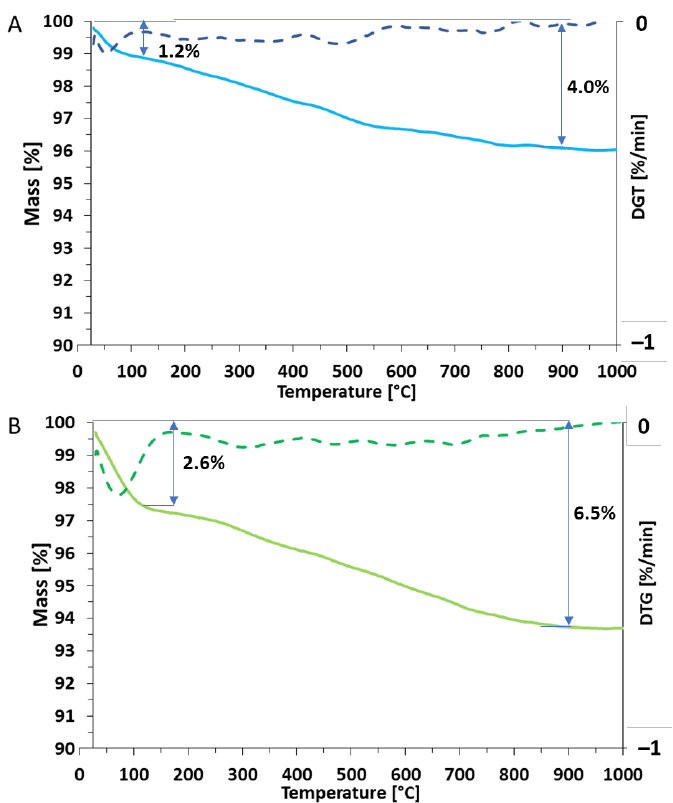
Figure 4. Results of thermogravimetric analysis TGA/DTG of both samples pyr SiO 2 ( A ) and bio SiO 2 ( B ).